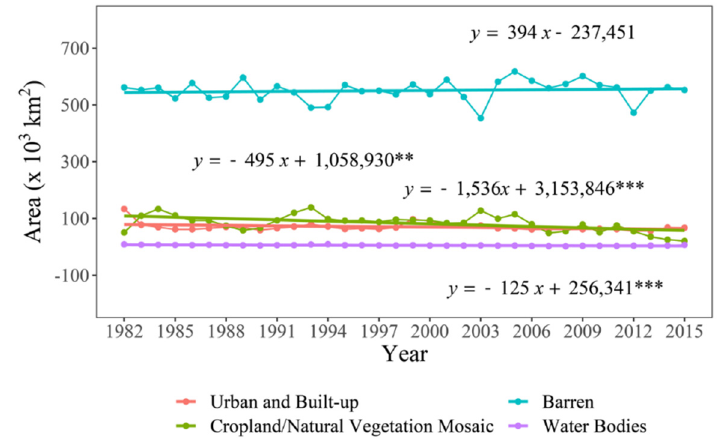
Figure A3. Temporal changes for the total areas of urban and built-up, cropland/natural vegetation